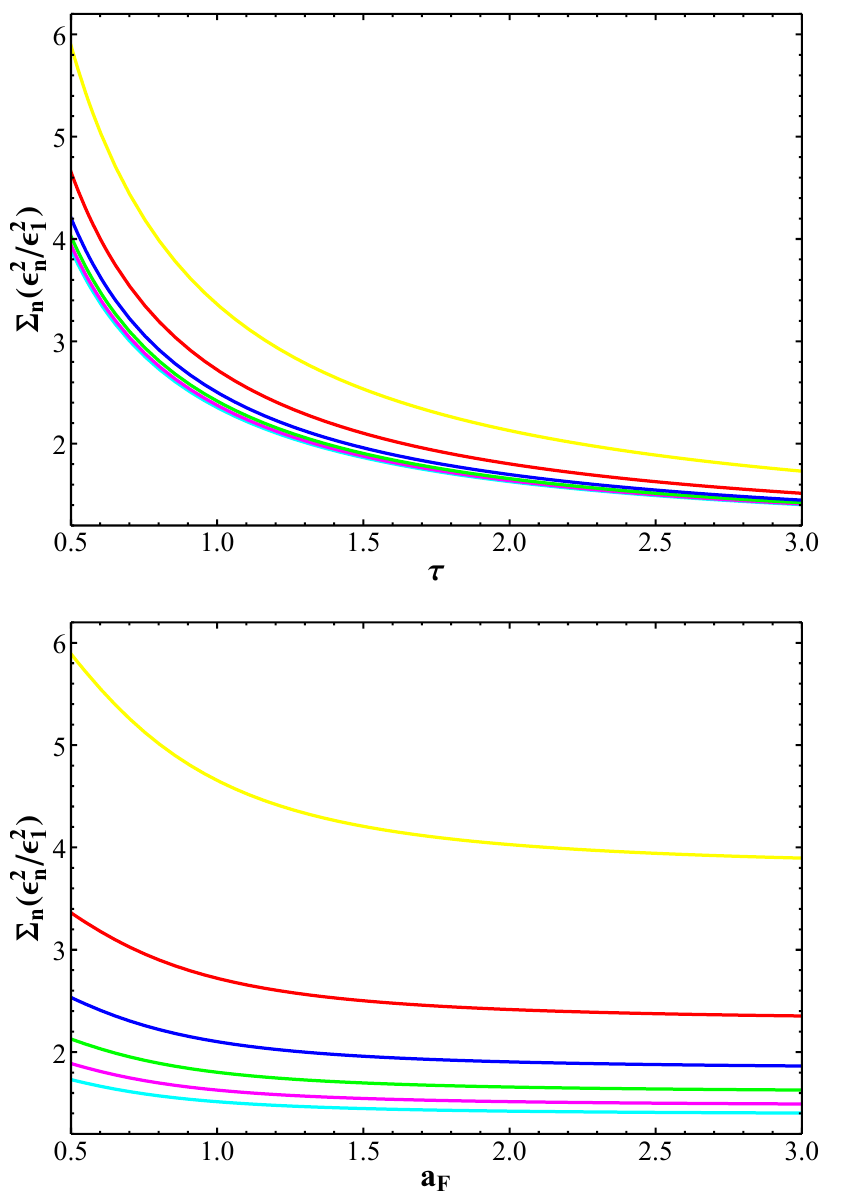
Figure 7 . (Top) The sum P (cid:15) 2 /(cid:15) 2 over all n , as a function of τ for a F = 3 (cyan), 5/2 (magenta), n 1 n 2 (green), 3/2 (blue), 1 (red), and 1/2 (yellow), respectively. (Bottom) As in the previous panel, but now as a function of a F assuming τ = 3 (cyan), 5/2 (magenta), 2 (green), 3/2 (blue), 1 (red), and 1/2 (yellow),